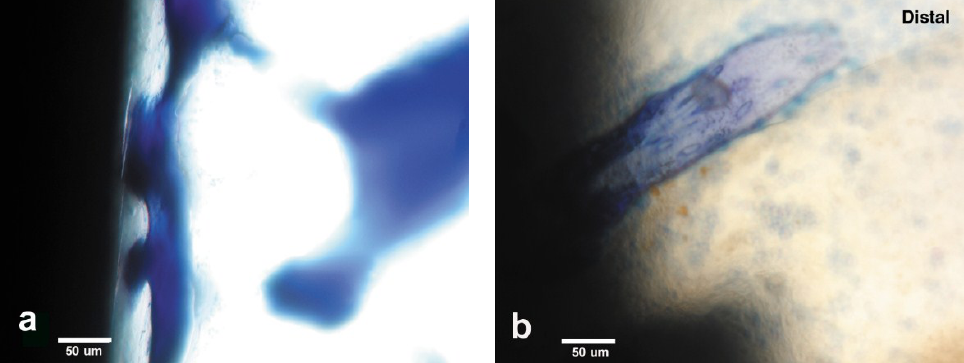
Figure 4. Toluidine blue stain osseointegration for lateral implant sections at 20× magnifications ( a ) Coordinated epoxy/carbon fiber osseointegration ( b ) Isolated titanium-6Al-4V osseointegration.